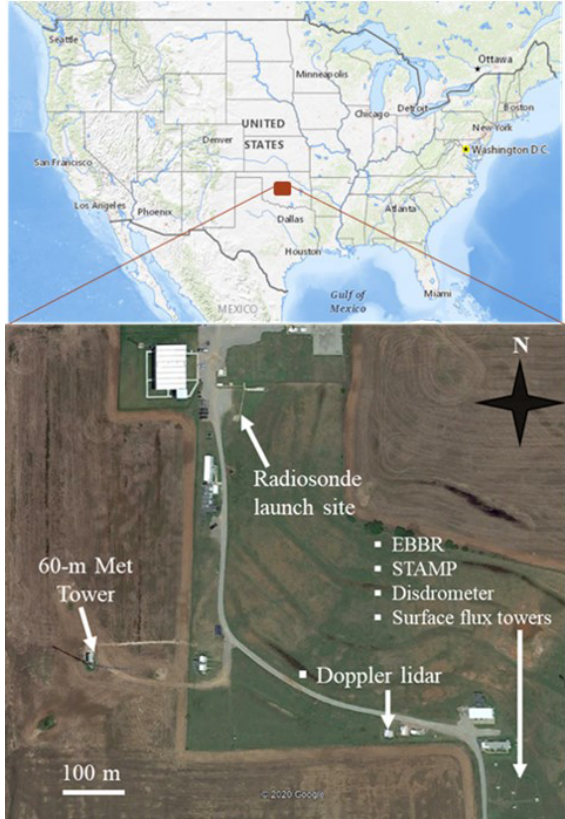
Figure 1. ARM SGP site C1 layout and instruments used in this study in Oklahoma, USA. Maps are extracted from © Google Earth and © Google